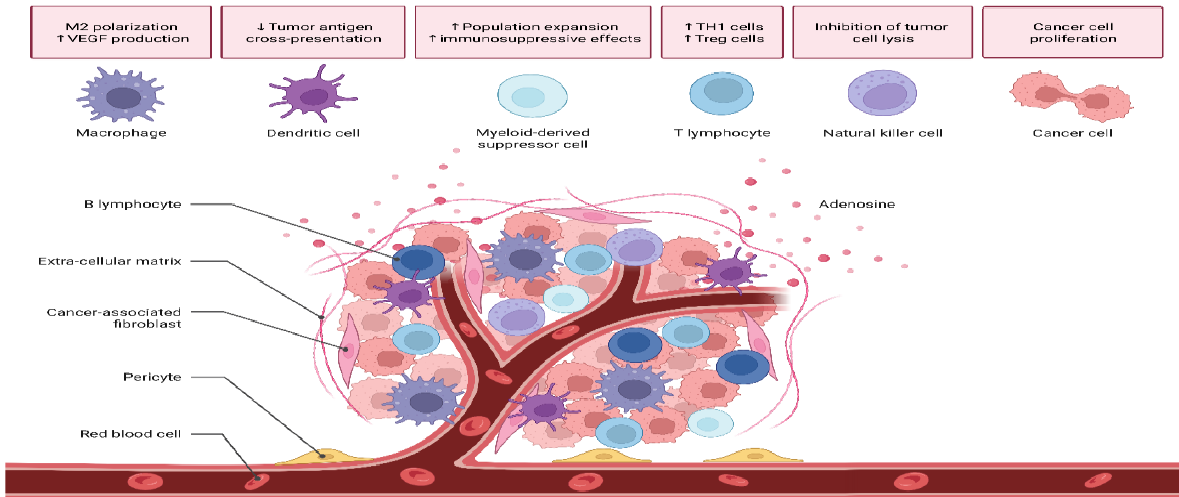
Figure 2. A diagrammatic representation of the microenvironment of a tumor highlighting the multiple cell phenotypes.